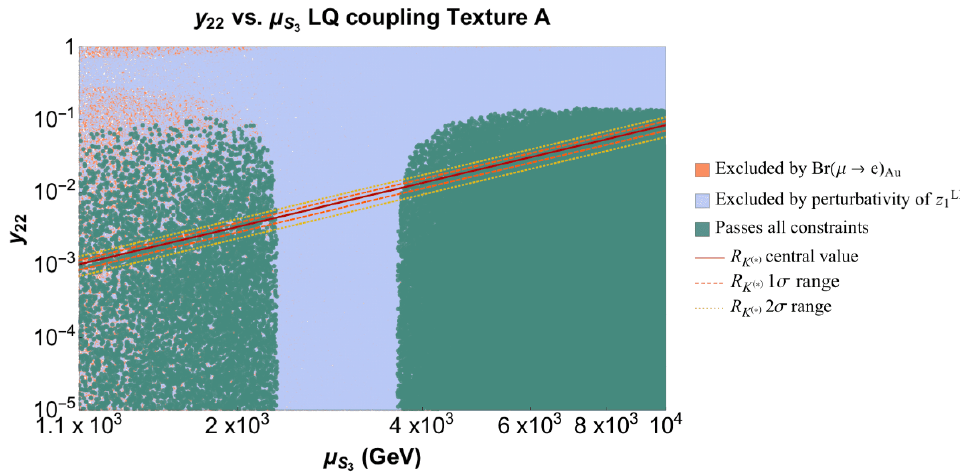
Figure 13 . Indicative plot of the allowed parameter space in the y 22 vs. (cid:22) S coupling matrix Texture A. The red line indicates the central value needed to explain the R anomalies with the dotted orange (yellow) lines indicating the 1(2) (cid:27) bounds. The orange region of the parameter space is constrained by Br( (cid:22) ! e ) Au , the teal region is allowed; speci(cid:12)cally it passes all constraints discussed in section 3 as well as perturbativity constraints on the diquark coupling constants z LL . The light blue region is excluded by perturbativity constraints on diquark couplings. 1 ij